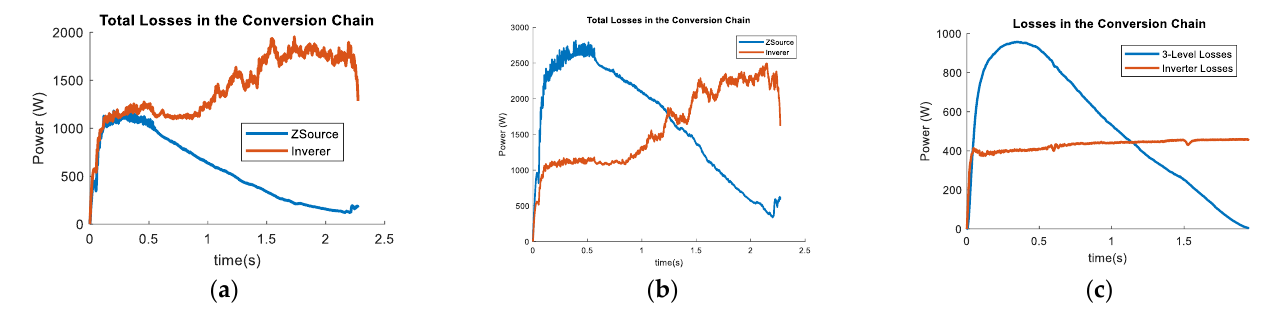
Figure 21. Overall losses in the powertrain conversion of ( a ) the two paralleled ST IGBT BqZSI topology, ( b ) single ST IGBT BqZSI topology, and ( c ) 3-level DC-DC/SVPWM.